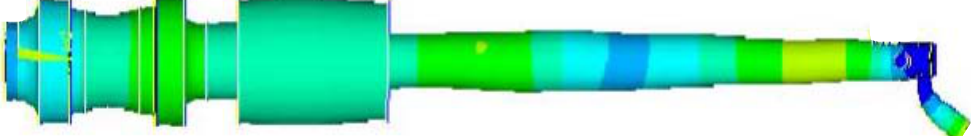
(a) Longitudinal mode shape of transducer of mode at 138